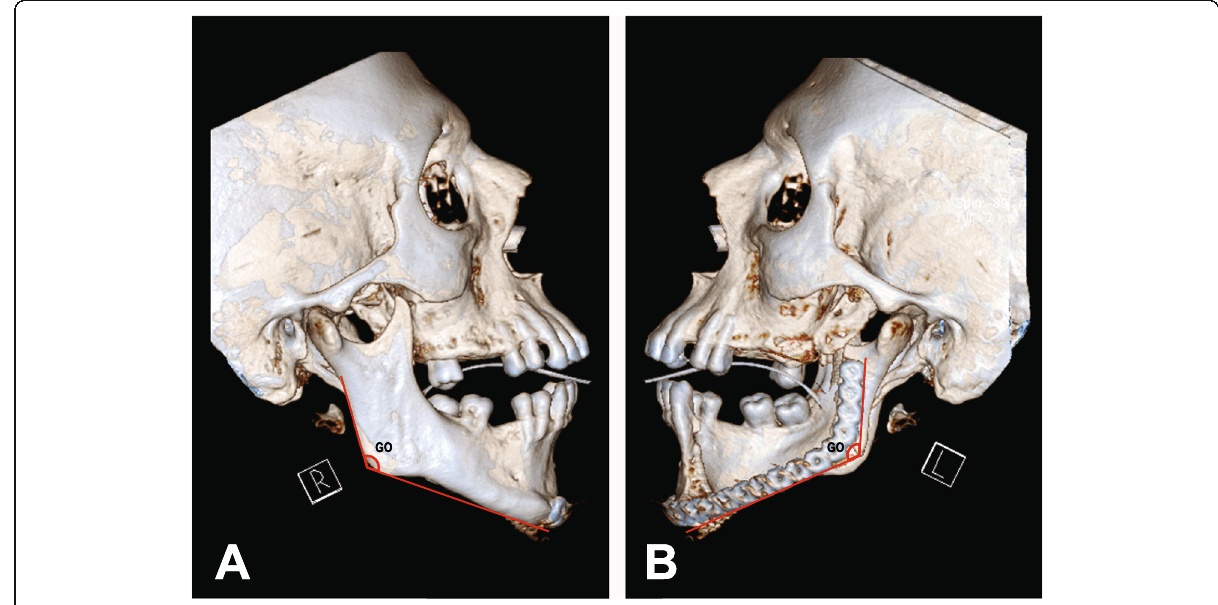
Fig. 3 a The measurement of a non-affected gonial angle in 3D-CT images (sagittal view), and b for reconstructed gonial